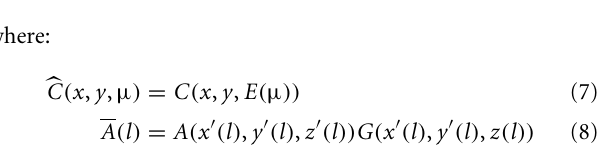
FIGURE 4 |Absorption efficiency of 3/8 (cid:48)(cid:48) -thick NaI (yellow curve), of 30mm-thick GSO (black curve), of 30mm-thick BGO (red curve), and of 30mm-thick CdWO4 (brown curve) .The solid curves were derived from Ref. (19).The dash curve (MC simulation) was extracted from Ref. (20).